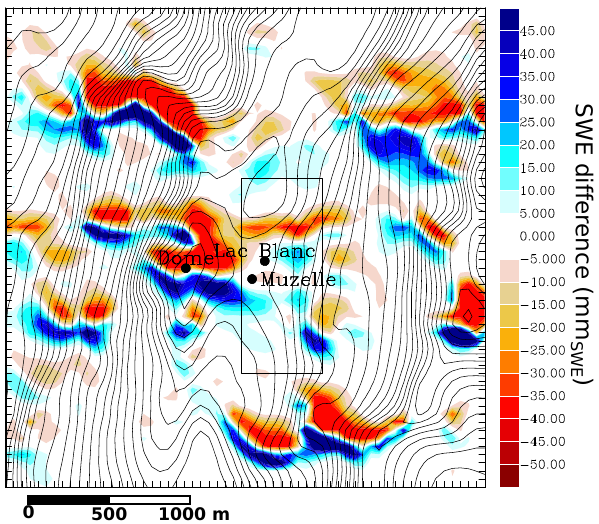
Fig. 9. Map of snow water equivalent (SWE, mm SWE ) difference simulated by Meso-NH/Crocus between 23:00 and 01:00 on 18 March 2011. Black isolines correspond to 1z = 25m and black box designates the area where data from terrestrial laser scanner are